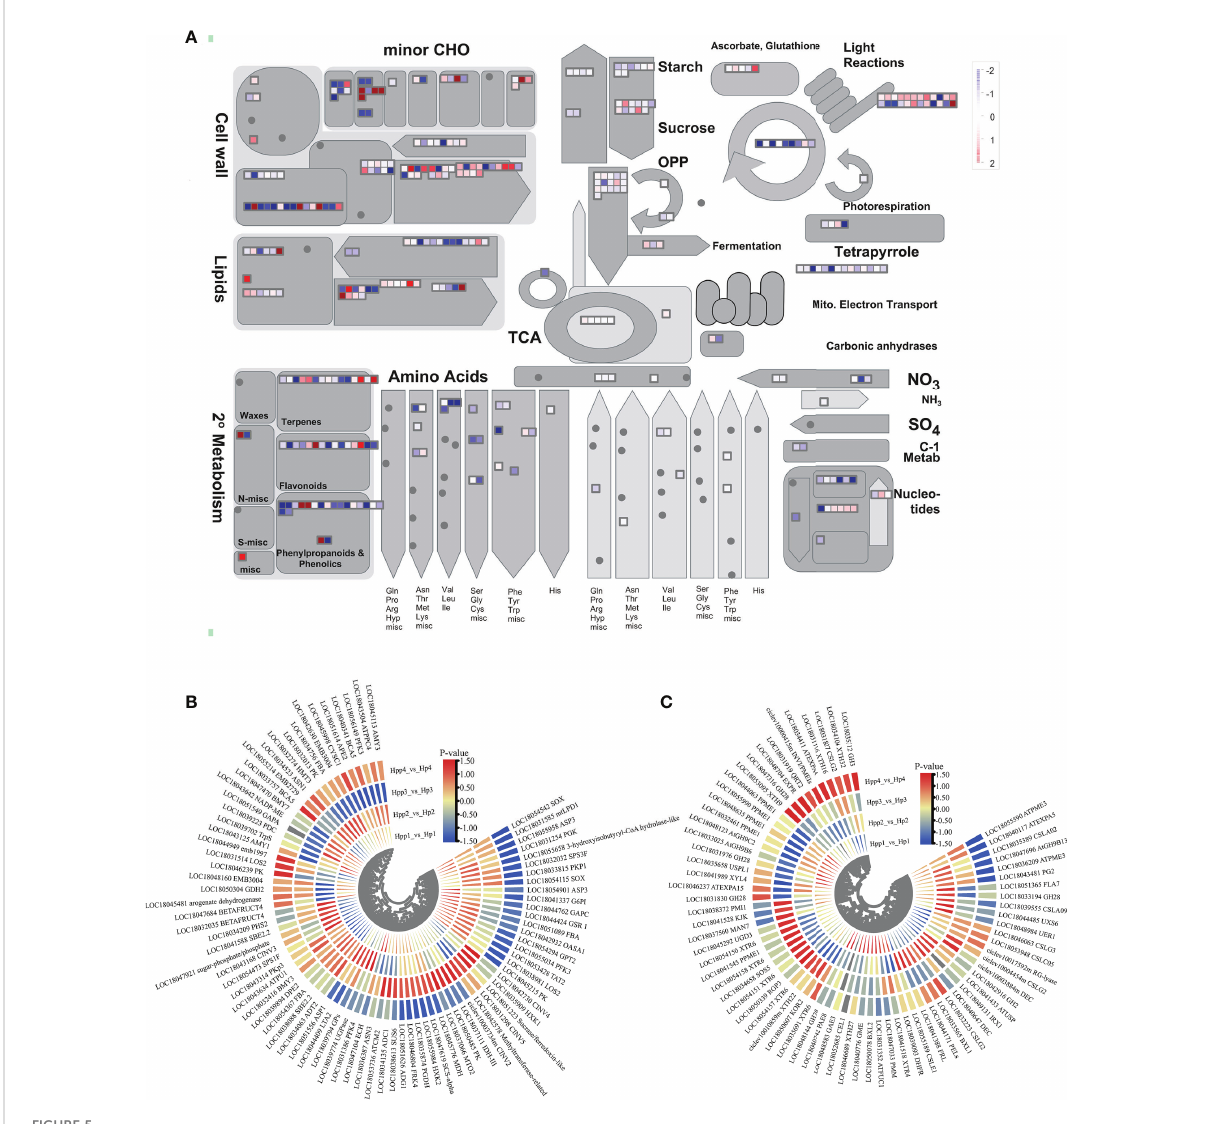
FIGURE 5 Differentially Expressed Endogenous Metabolism-Related Genes between Harumi/Hongjv (HP) and Harumi/Ponkan/Hongjv (HPP) fruits. (A) MapMan-based “ metabolic-overview map ” of differentially expressed genes (DEGs) (Harumi/Hongjv (HP) group vs Harumi/Ponkan/Hongjv (HPP) group) at four different developmental stages. (B) DEGs related to starch, sucrose, and tricarboxylic acid (TCA) metabolism during tangor fruit development and ripening. (C) DEGs related to cell wall metabolism during tangor fruit development and ripening. Heatmap of DEGs was drawn using the log2fold-change value obtained from the pairwise comparison of samples. Red and blue indicate upregulation and downregulation, respectively, in the former of the